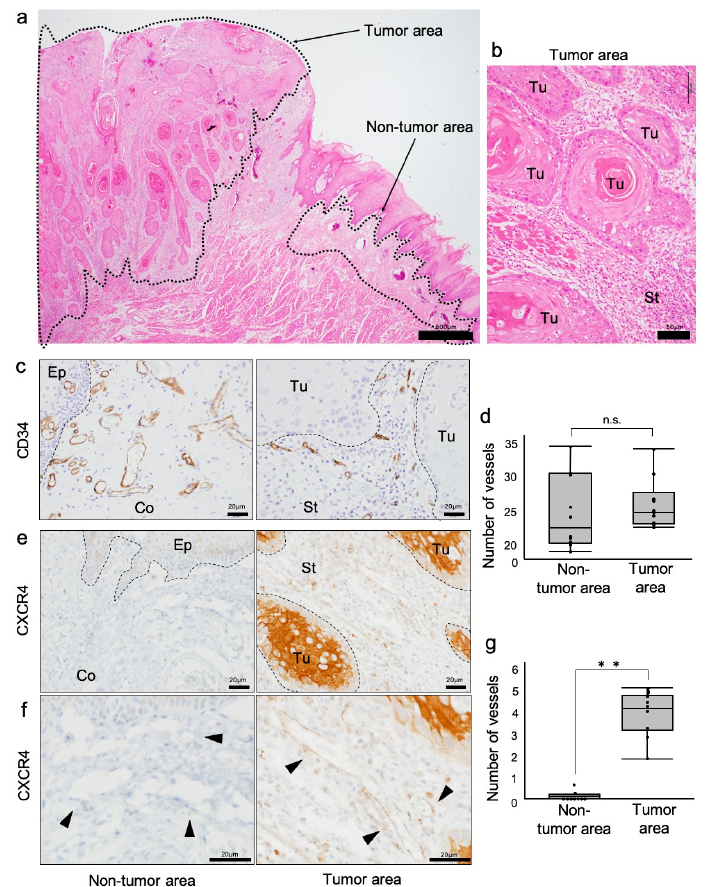
Figure 1. Investigation of CXCR4-positive and CD34-positive vessels in oral squamous cell carcinoma (OSCC) stroma. ( a ) HE staining of an OSCC tissue for the definition of the tumor and nontumor areas. Tumor and nontumor areas are surrounded by dotted lines. ( b ) High-power magnification of tumor area stained with HE. Tu: tumor. St: stroma. ( c ) Immunohistochemistry (IHC) for CD34 in tumor and nontumor areas. Borders between epithelia (Ep), connective tissue (Co), tumor (Tu), and stroma (St) are shown with dotted lines. ( d ) The average number of vessels in the tumor and nontumor areas in a representative OSCC case. p = 0.289, n.s., not significant, N = 10 cases. ( e ) IHC for CXCR4 in tumor and nontumor areas. ( f ) High magnification IHC for CXCR4. Arrowheads indicate vessels. CXCR4-positive vessels specifically existed in the tumor area. ( g ) The average number of CXCR4-positive vessels in the tumor and nontumor areas in a representative OSCC case. ** p < 0.0001, N = 10